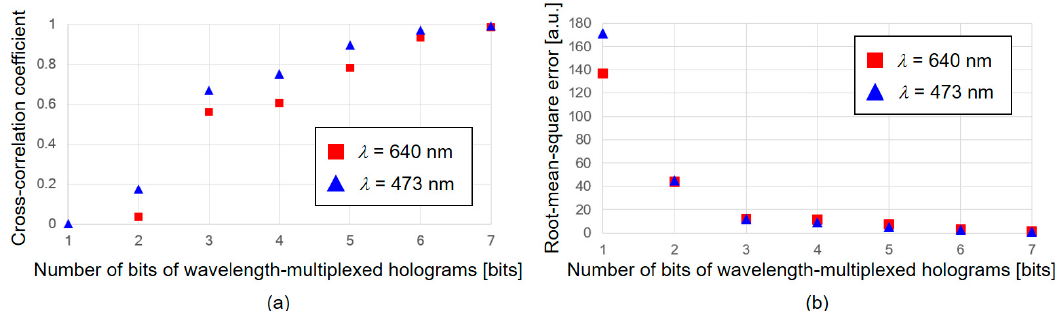
Figure 3. Quantitative evaluations of experimental results: ( a ) cross-correlations coefficient (CC) and ( b ) root-mean-square error (RMSE) of the reconstructed amplitude images.